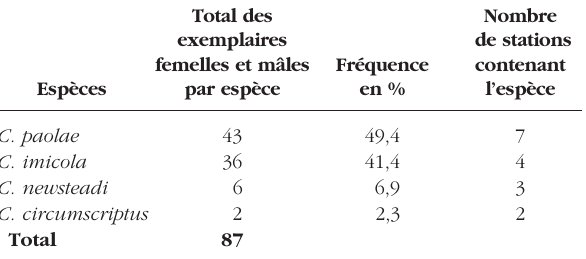
Tableau IV. – Fréquence des espèces capturées au piège